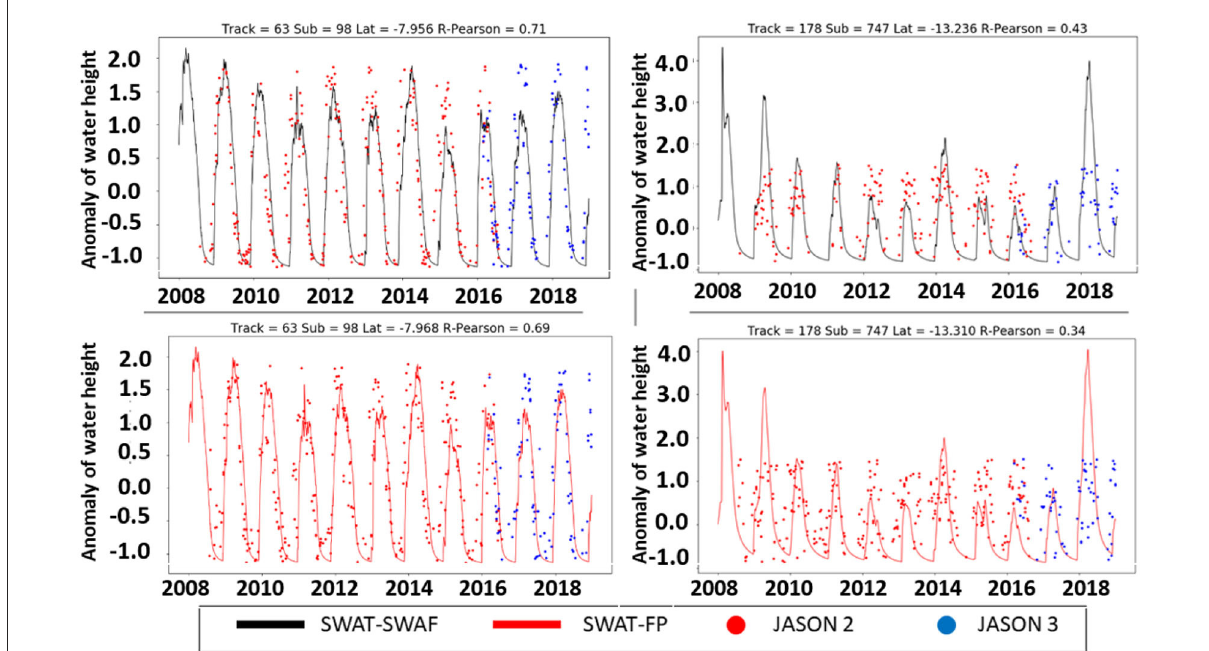
FIGURE7 Comparison of water height variations in the floodplain between the SWAT-SWAF/SWAT-FP framework and altimetry data from 2008 to 2018. The dots refer to measurements of anomalies of water height from altimeters Jason 2 (red) and Jason 3 (blue) in floodplains. The lines represent the simulated anomalies of water height in floodplains from the SWAT-SWAF framework (black) and SWAT-FP